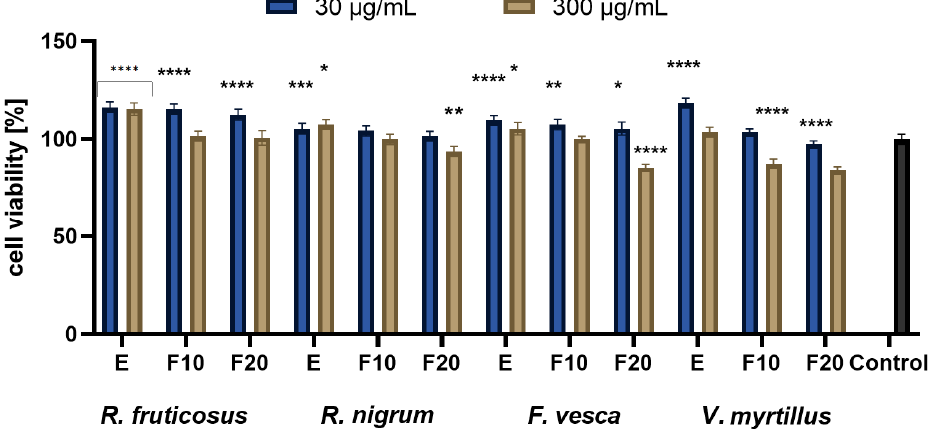
Figure 6. The effect of 24 h exposure of the R. fruticosus L., R. nigrum L., F. vesca L., V. myrtillus L. extract and kombucha ferments (at concentrations of 30 and 300 µ g/mL) on Neutral Red Dye uptake in cultured fibroblasts (BJ). Data are the mean ± SD of three independent experiments, each of which consists of three replicates per treatment group. **** p < 0.0001, *** p < 0.0008, ** p < 0.0010, * p < 0.0036 versus the control (100%).